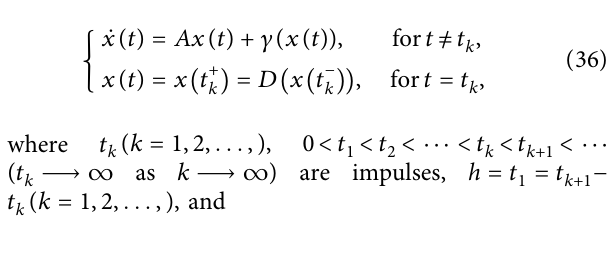
Figure 5: The trajectory of the finite-time Lyapunov function V for system (31) with the initial condition x ( 0 ) � (− 6 , 2 ) T and the resetting time t k � 5 k,k � 1 , 2 , ... , .